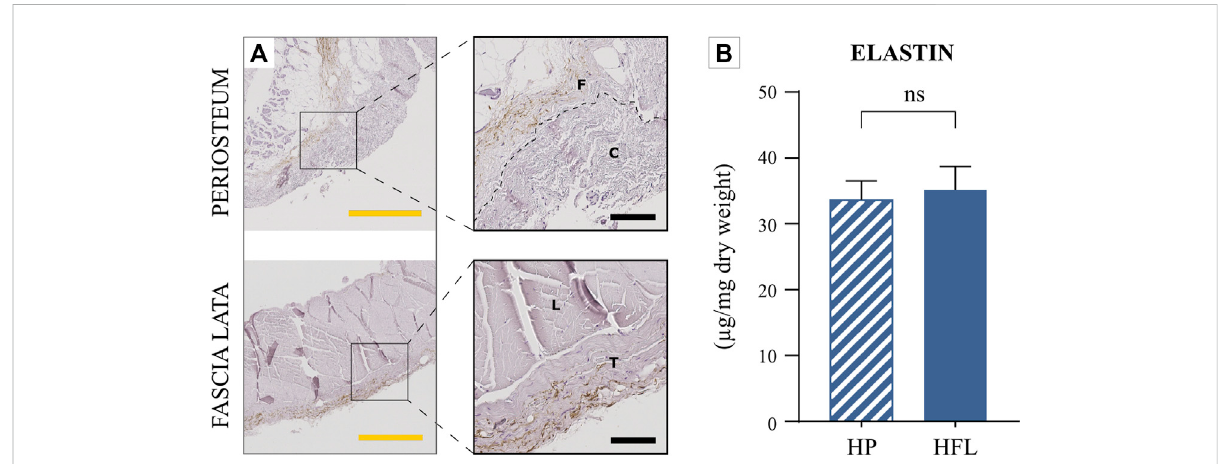
FIGURE 5 Comparison of the HP and HFL by immunohistochemistry for elastin (A) (including zoom in) and elastin quanti fi cation ( N = 4 donors x three samples from each donor leading to n = 12 specimens analyzed for each tissue) (B) . C: cambial layer, F: fi brous layer, L: longitudinal layer, T: transverse layer, HP: human periosteum, HFL: human fascia lata. Black scale bars: 100 µm. Yellow scale bars: 500 µm, ns: non-signi fi cant.